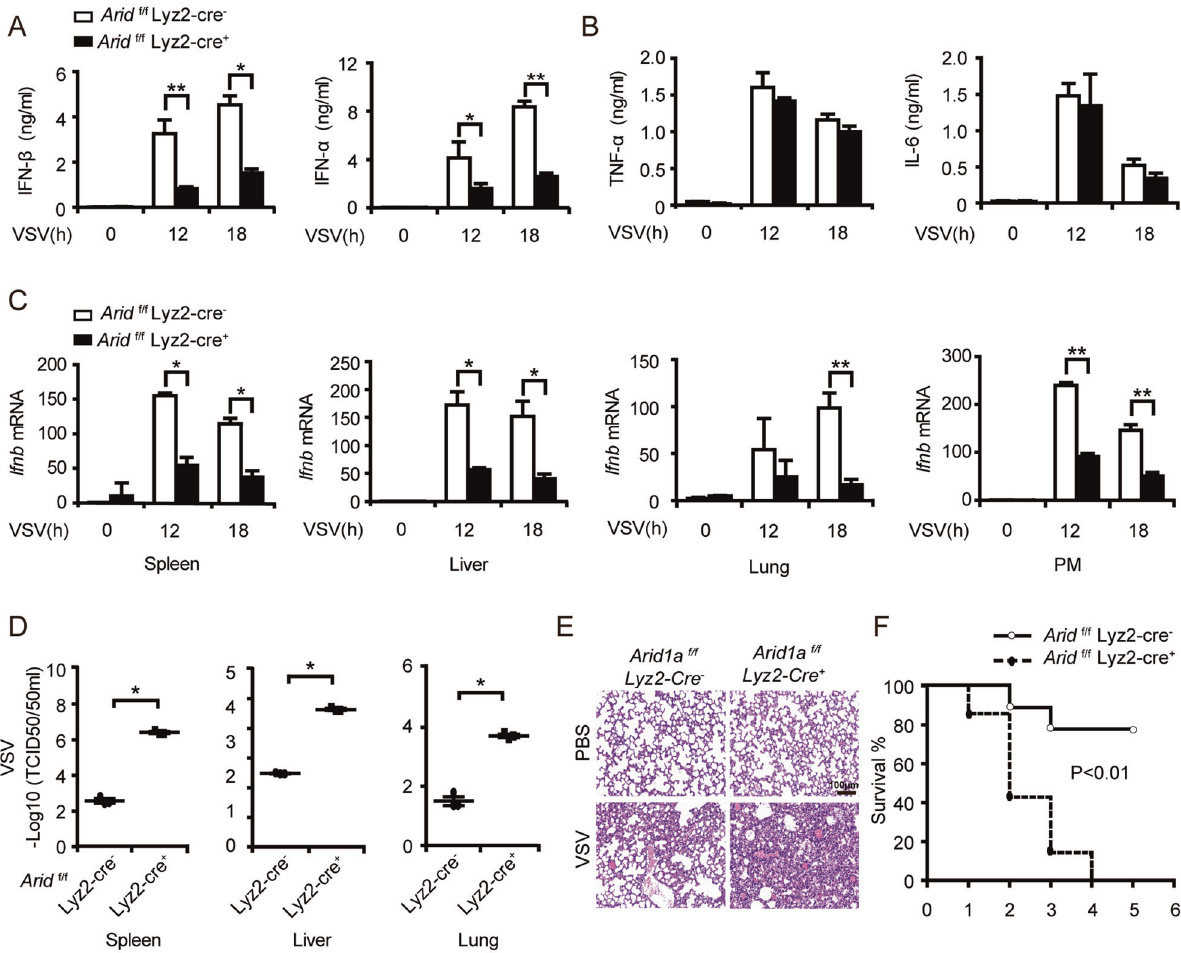
Fig. 2 Arid1a -de fi cient mice are more susceptible to VSV infection. A ELISA analysis of IFN-I in the serum of Arid1a f/f Lyz-Cre − and Arid1a f/f Lyz-Cre + mice infected with VSV (5 × 10 7 pfu/g, n = 3 per group) at indicated times. B ELISA analysis of TNF- α and IL-6 in the serum of mice treated as in ( A ). ( C ) qPCR analysis of Ifnb expression in spleen, lung, liver and PMs of mice treated as in ( A ). D TCID50 assay of VSV load in spleen, lung, and liver of Arid1a f/f Lyz-Cre − and Arid1a f/f Lyz-Cre + mice 18 h after VSV infection (5 × 10 7 pfu/g, n = 3 per group). E HE staining of the lung tissue from mice treated as ( D ) (scale bar: 100 μ m). F Survival curve analysis of Arid1a f/f Lyz-Cre − and Arid1a f/f Lyz-Cre + mice intravenously injected with VSV (1 × 10 8 pfu/g, n = 7 per group). Kaplan – Meier survival curves were generated and analyzed for statistical signi fi cance with GraphPad Prism 5.0. Error bars represent s.d. Student ’ s t -test. * P < 0.05, ** P < 0.01. All data are representative of three independent experiments with three biological replicates. ( A – D : mean ±